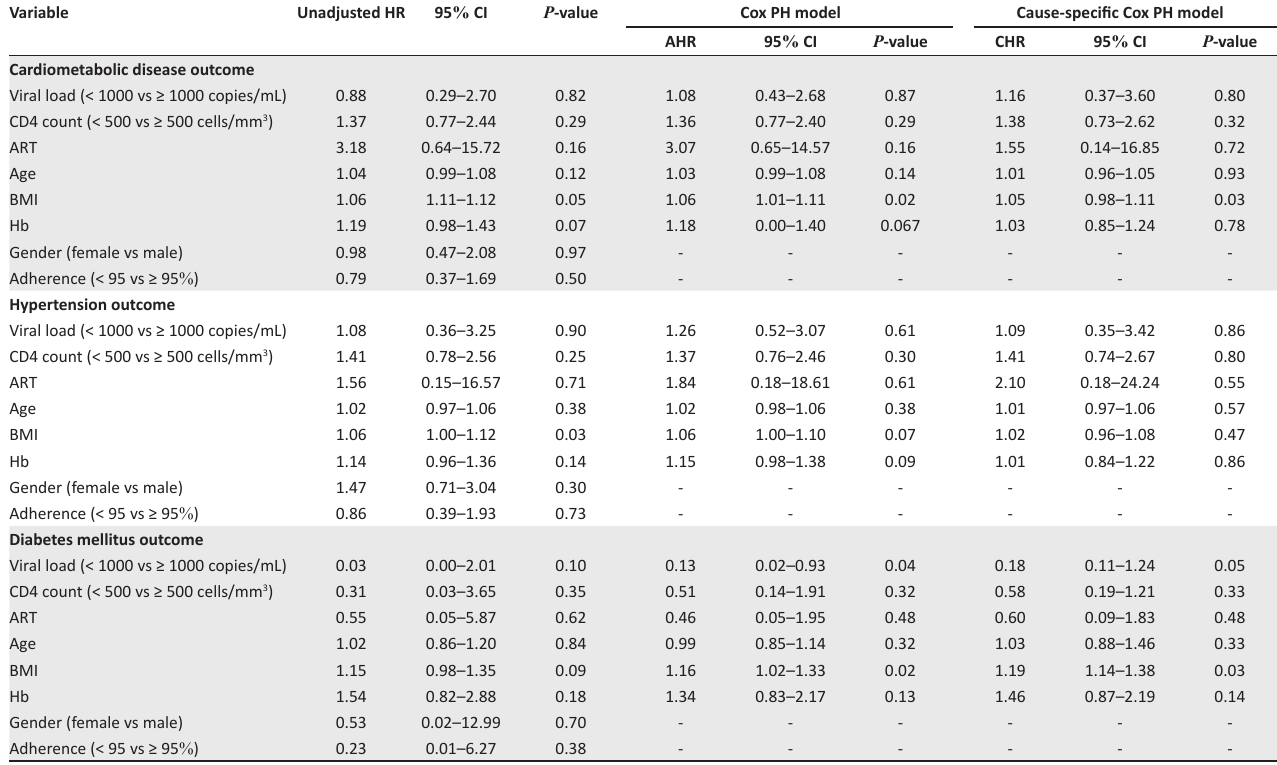
TABLE 4: Risk factors for cardiometabolic disease, hypertension and diabetes mellitus. Variable Cardiometabolic disease